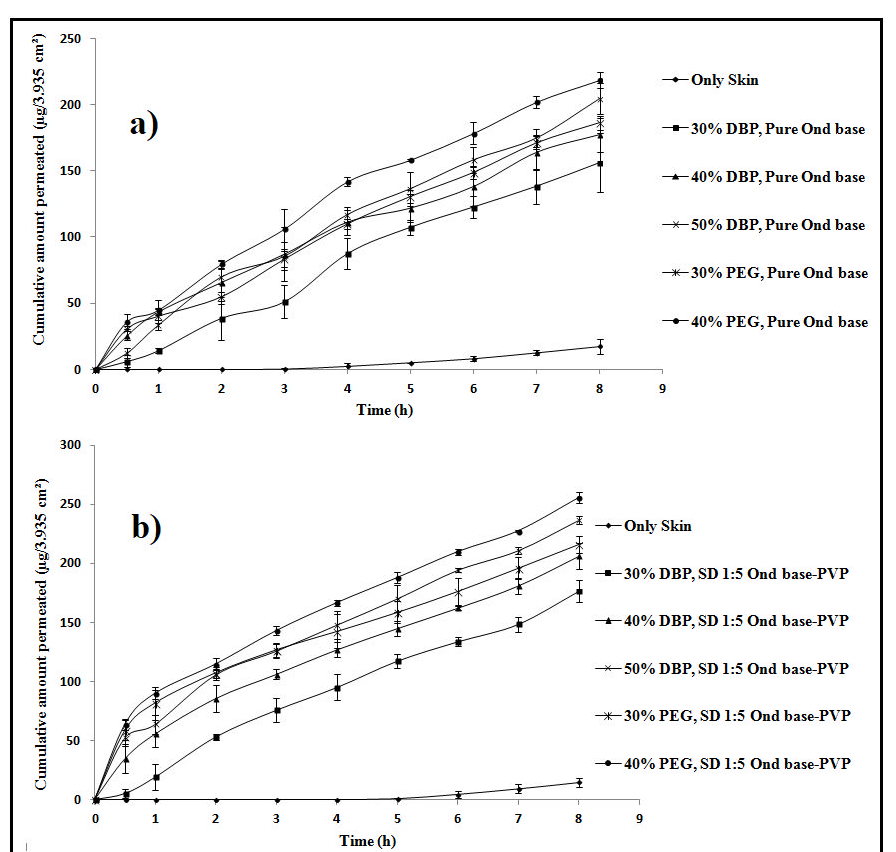
TABLE VIII - Permeation parameters of different formulations ( n=3 )